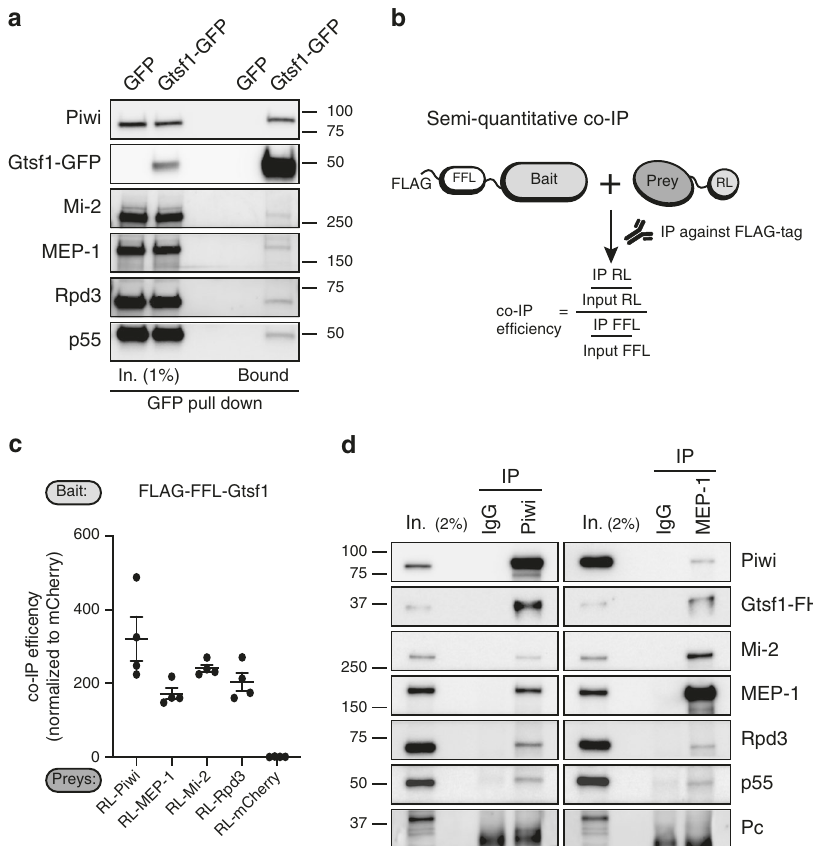
Fig. 1 Piwi and Gtsf1 interact with MEP-1, Mi-2, Rpd3 and p55 in OSCs. a Western blot analysis of co-immunoprecipitation (co-IP) of Gtsf1-GFP from OSC nuclear extract using GFP-Trap. Control IPs were performed with OSCs transfected with a GFP-expressing vector. b Principle of dual-luciferase co-IP. A bait protein is fused to FLAG-tagged Fire fl y luciferase (FLAG-FFL), whereas potential interactors (preys) are fused to Renilla luciferase (RL). Following transient co-expression in S2R + cells, the bait is immunoprecipitated with anti-FLAG antibodies and the co-IP ef fi ciency is quanti fi ed by monitoring FFL and RL activities. c Graph shows the normalized co-IP ef fi ciency (co-IP ef fi ciency normalized to the RL-mCherry co-IP, this latter being used as a control of non- interacting prey) between the Gtsf1 bait and the indicated RL preys: Piwi, MEP-1, Mi-2, and Rpd3. Dots show values for n = 4 biologically independent samples, lines represent mean values ± SEM. d Western blot analysis of co-IP of endogenous Piwi and MEP-1 from Gtsf1-FH-containing OSC nuclear extract using anti-Piwi (left panel) and anti-MEP-1 (right panel) antibodies. Mouse and rabbit IgGs were used as control IPs for Piwi and MEP-1, respectively. The amount of input (In.) loaded relatively to IP is indicated as a percentage. Source data: c : Supplementary Data set 2; uncropped blot images are provided in Supplementary Data set